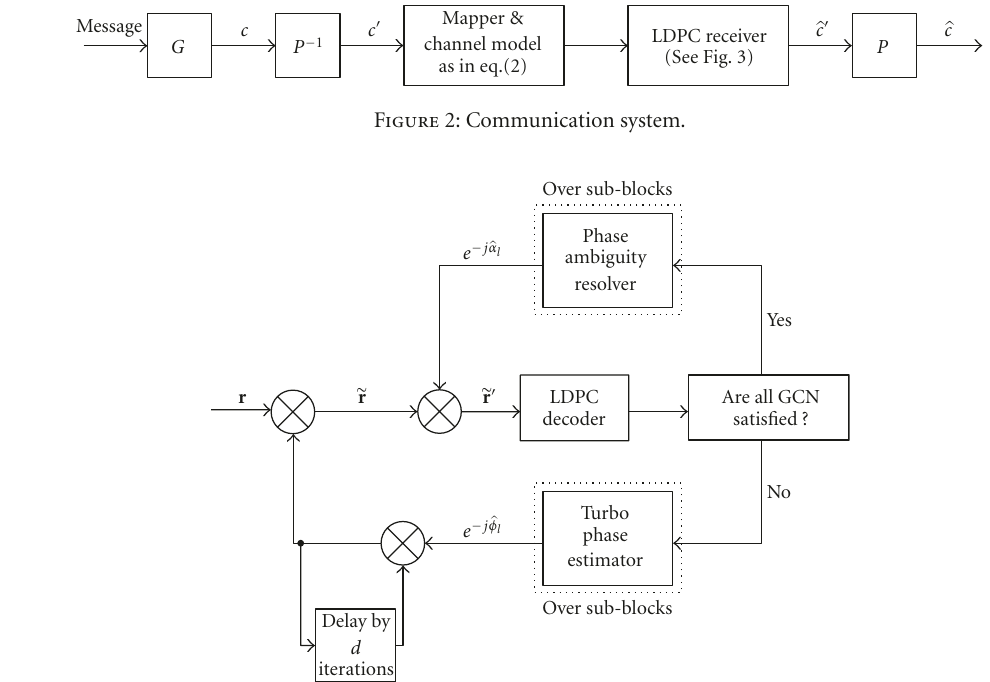
Figure 3: Proposed LDPC receiver architecture.